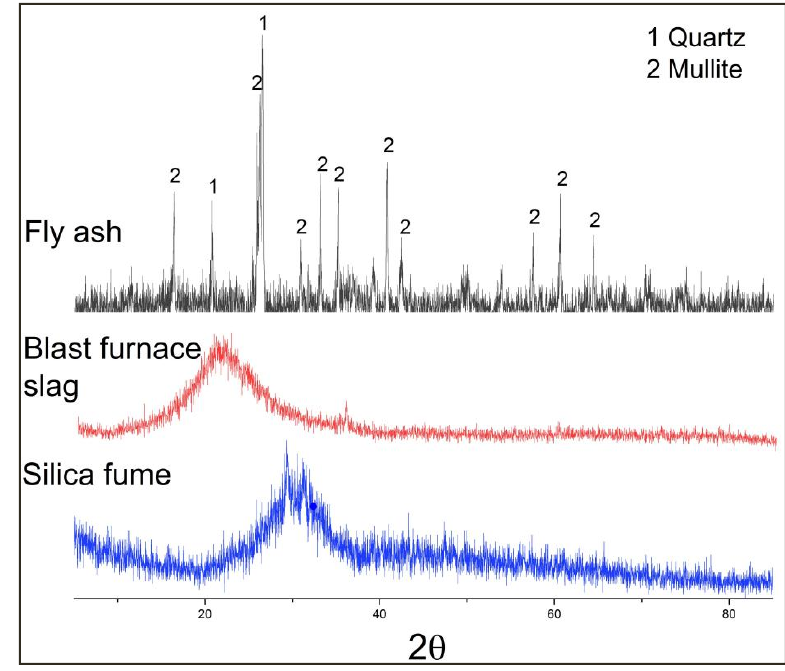
Figure 2. XRD analysis of fly ash, blast furnace slag, and silica fumes.